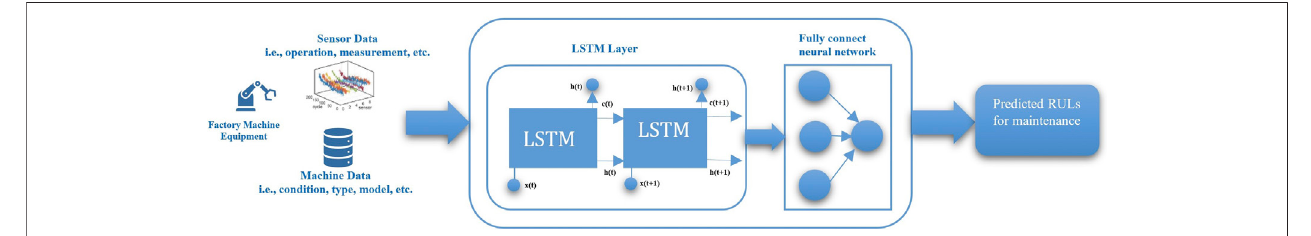
FIGURE 4 | PMMI 4.0 predictive RUL model for maintenance.